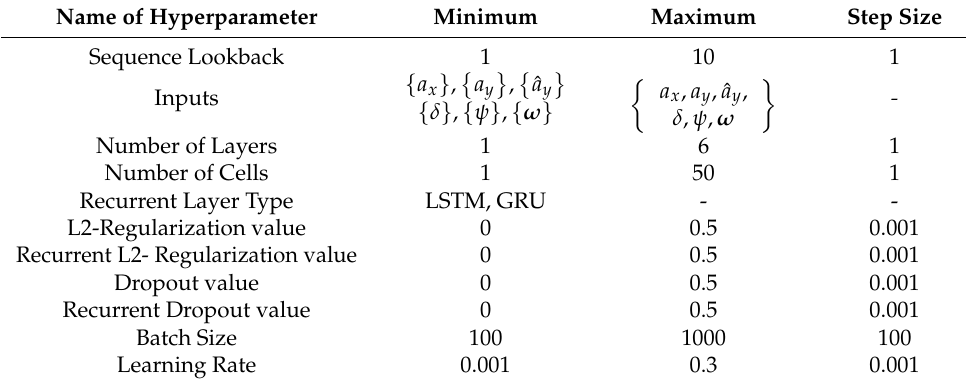
Table 4. Variable hyperparameter and their parameter